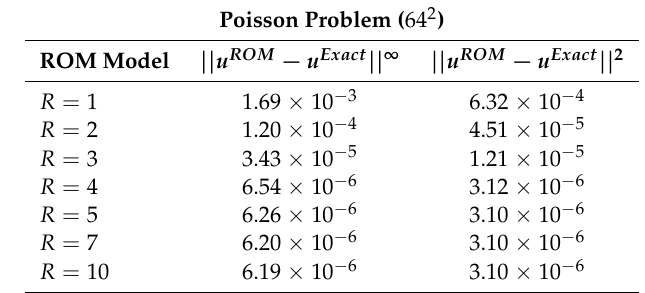
Figure 4. Relaxation histories for the first two modal coefficients. ( a ) a 1 ( τ ) ; ( b ) a 2 ( τ ) . Table 1. A quantitative analysis and predictive performance of the reduced order modeling (ROM) framework for the canonical elliptic problem solving the Poisson equation.